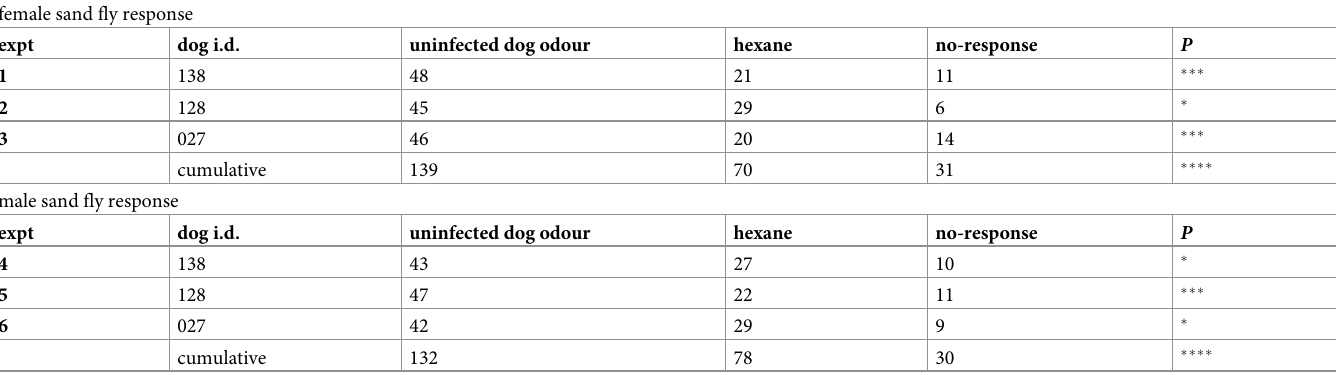
Female and male sand fly response = control experiments measuring either the response of the female or male sand flies in the Y-tube olfactometer; expt =